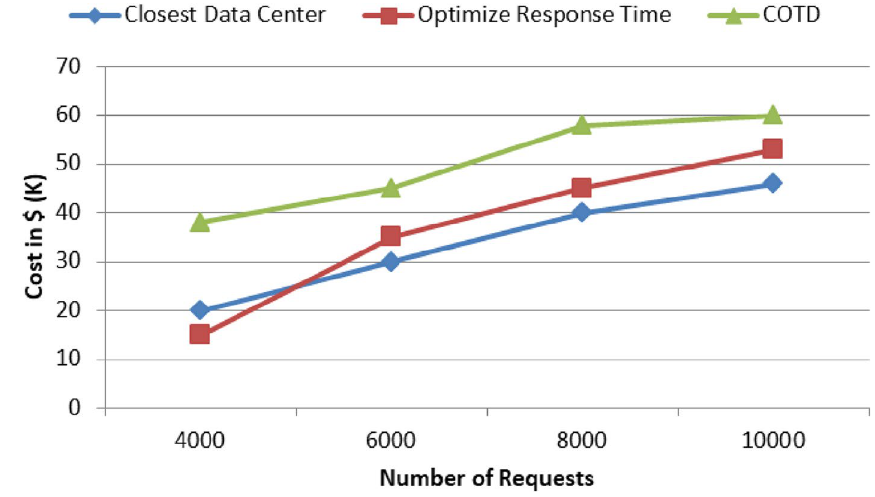
Fig. 12 Impact of COTD on cost increasing user requests